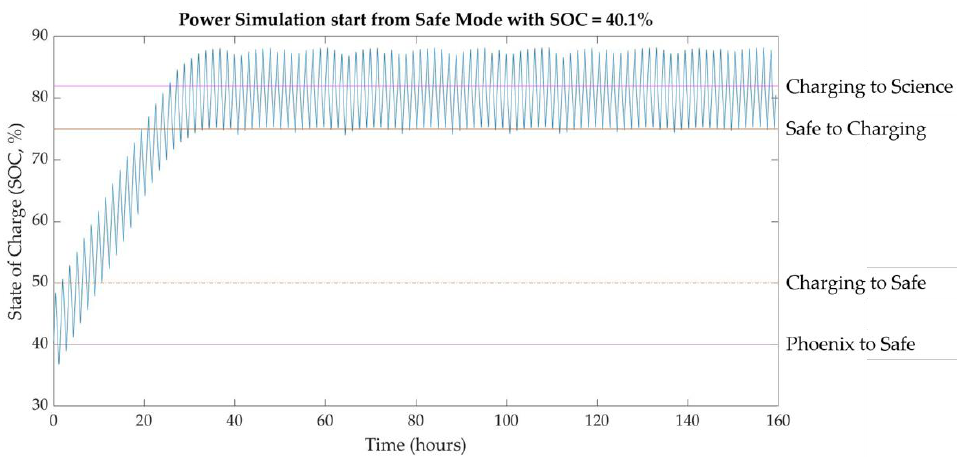
Figure 5. Simulation of IDEASSat SOC as a function of time starting from transition from phoenix to safe. Mode transition levels indicated by horizontal lines. safe. Mode transition levels indicated by horizontal